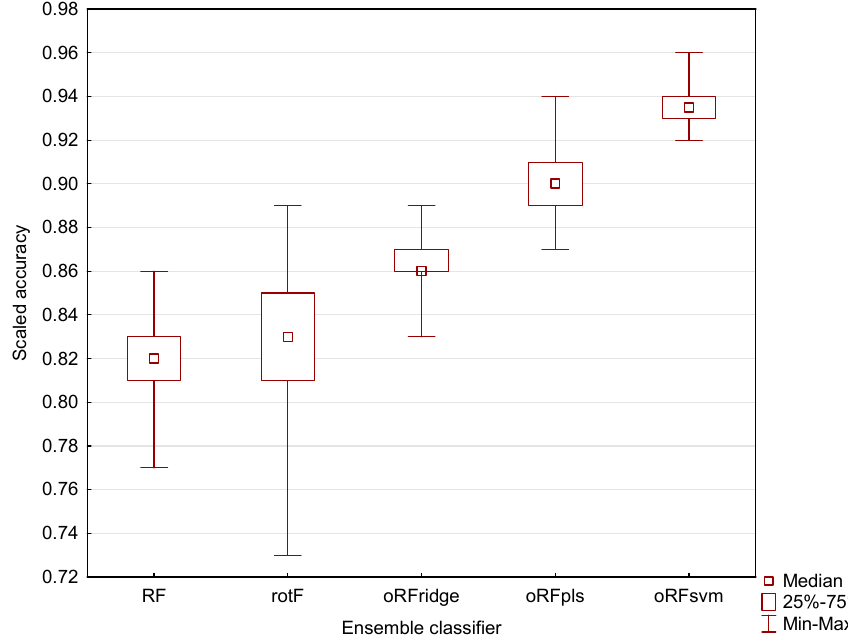
Figure 5. The distribution of the classification accuracy based on the test dataset for all tree-based algorithms (RF = random forest; rotF = rotation forest; oRFridge = oblique random forest using ridge regression as splitting model; oRFpls = oblique random forest using PLS as splitting model; oRFsvm = oblique random forest using SVM as splitting model) considered in this study. Each boxplot represents the results obtained from 100 repetitions and all bands ( n = 1769). The scaled accuracy is the classification accuracy represented on a scale ranging from zero to one.